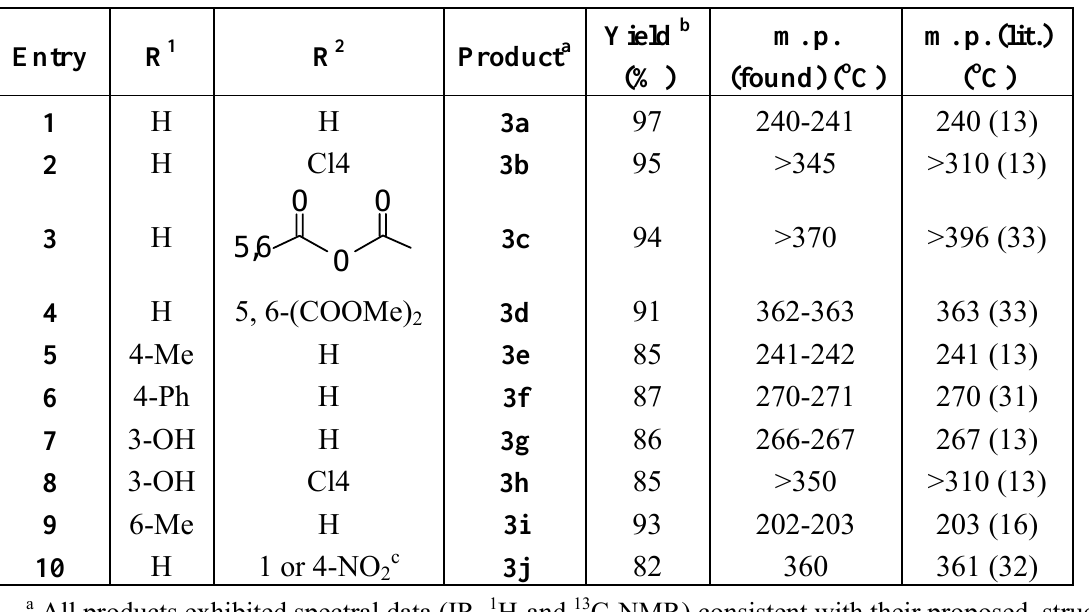
Table 2. Preparation of quinophthalones from phthalic anhydrides and 2-methyl- quinolines under microwave